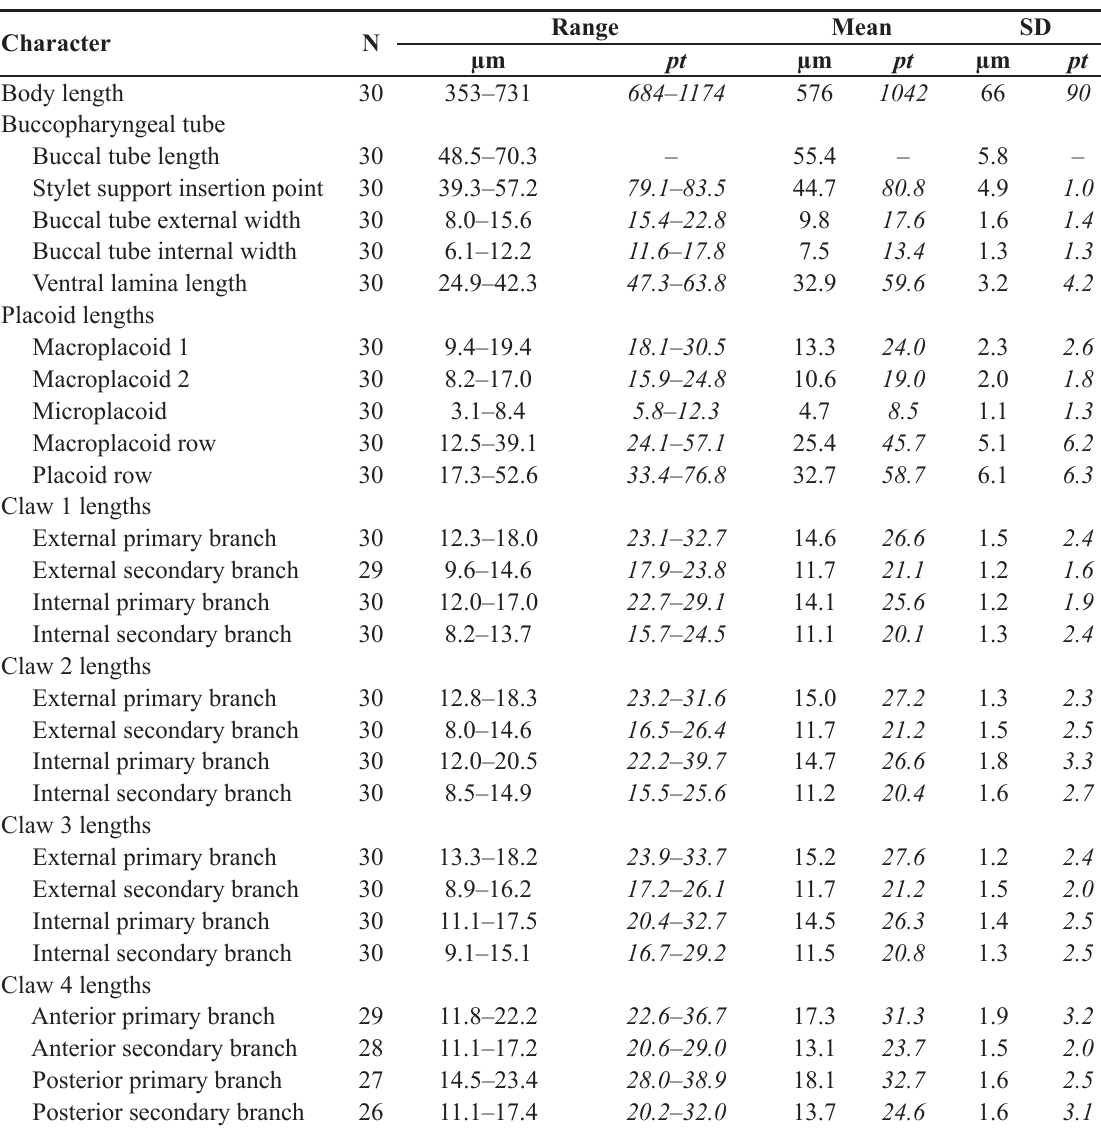
Table 7. Measurements (in µm) of selected morphological structures of individuals of Macrobiotus cf. recens Cuénot, 1932 from the Canary Islands mounted in Hoyer’s medium. (N = number of specimens / structures measured; Range = the smallest and the largest structure among all measured